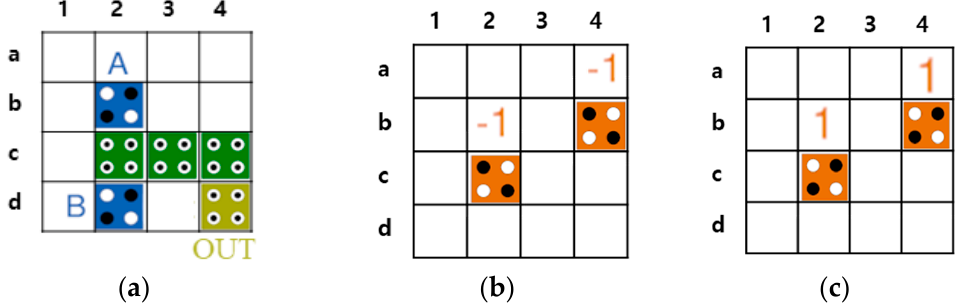
Figure 9. Proposed XOR/XNOR gates: ( a ) Layer 1-common structure; ( b ) Layer 2-XOR structure; ( c ) Layer 2-XNOR structure.